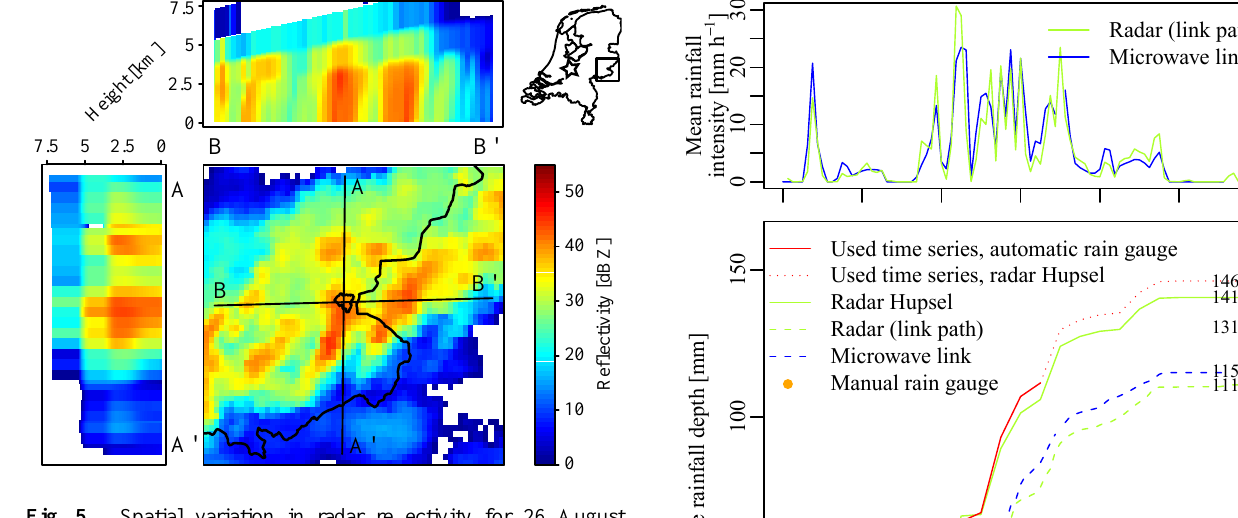
Fig. 5. Spatial variation in radar reflectivity for 26 August, 19:15UTC. Reflectivity is derived from the 14-elevation volume scan of the KNMI weather radar in De Bilt (star). Side panels show the vertical distribution of the reflectivity for two transects over the Hupsel Brook catchment.